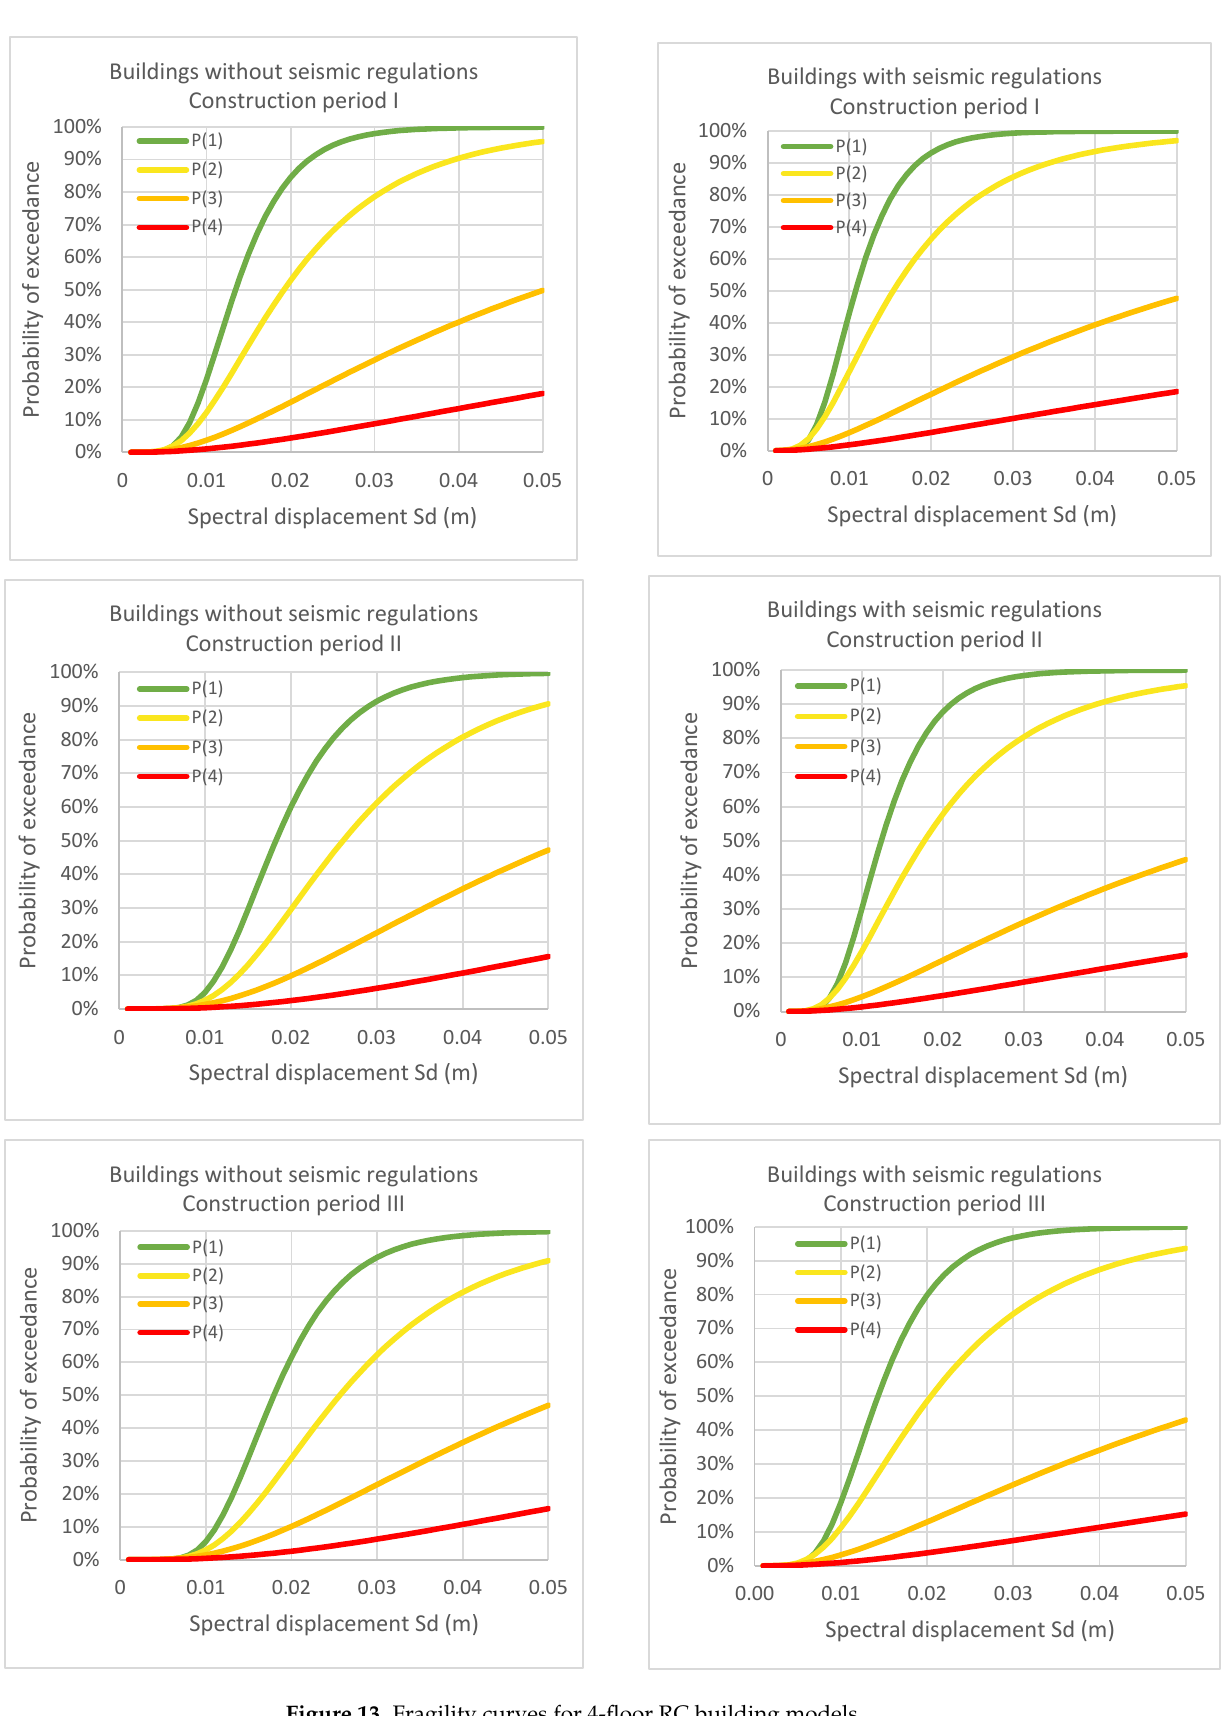
Figure 13. Fragility curves for 4-floor RC building models.